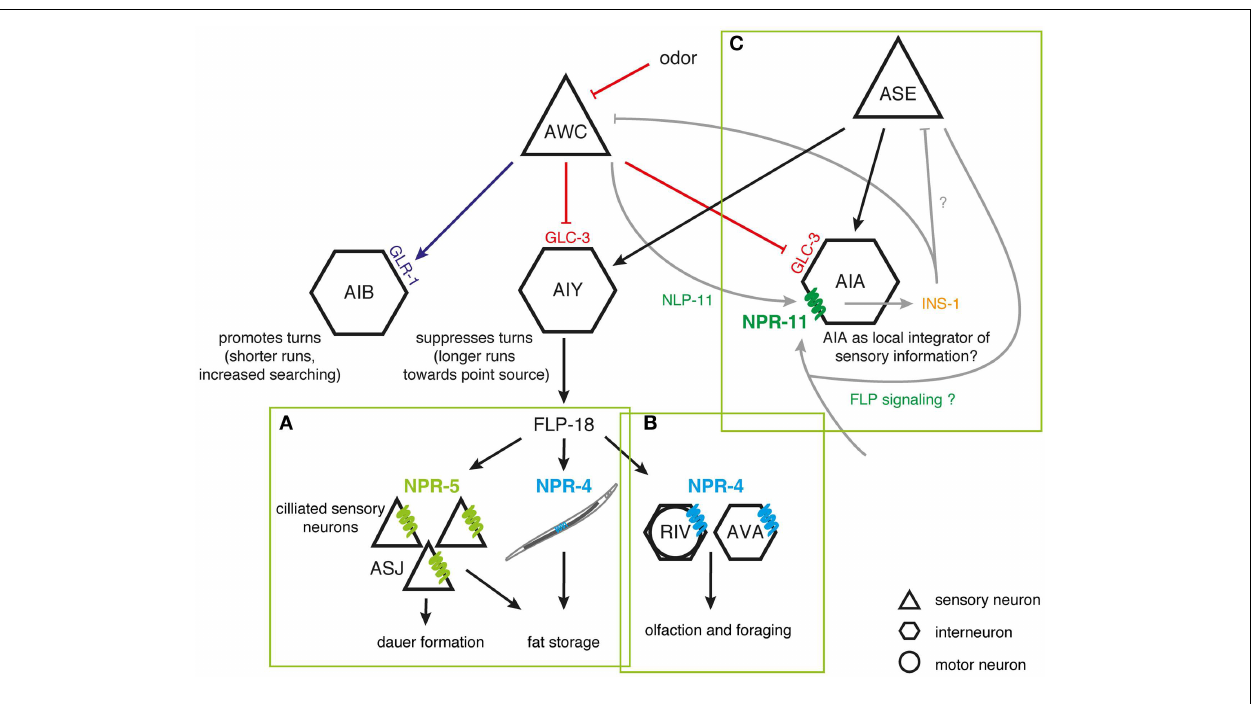
modulates sensory responses in C. elegans . In response to odor, the AWC olfactory neuron releases NLP-1 neuropeptides, which act on the NPR-11 receptor on AIA to modulate INS-1 peptide secretion. INS-1 subsequently closes the feedback loop by modulating AWC’s responsiveness to sensory stimuli. AIA could act as a local integrator of sensory information, with FLP sensory peptides driving similar neuropeptidergic feedback loops to modulate the responsiveness to sensory stimuli [adapted from Ref. (62,